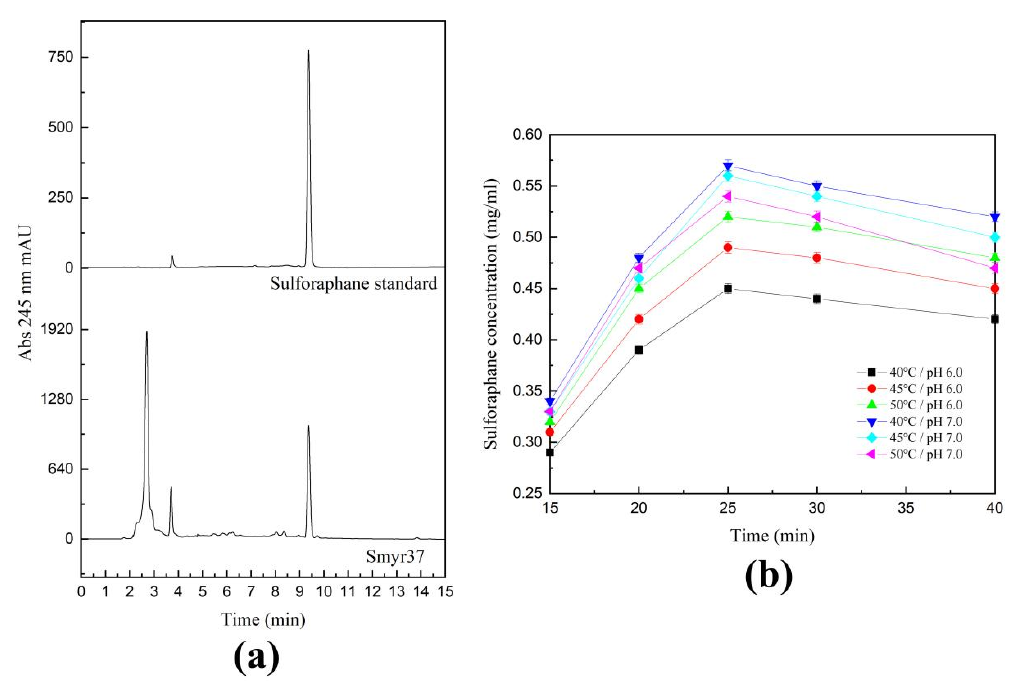
Figure 6. Optimization of the reactions for sulforaphane production by Shewanella baltica Myr-37 myrosinase. Due to the low purification efficiency, the crude enzyme of Smyr37 was used to hydrolyze glucoraphanin. The additive content of crude enzyme was 250 μ g/mL. ( a ) High-performance liquid chromatography analysis at 245 nm of the content of sulforaphane in the hydrolysis reaction mixture. ( b ) Effects of temperature, pH, and reaction time on sulforaphane accumulation.